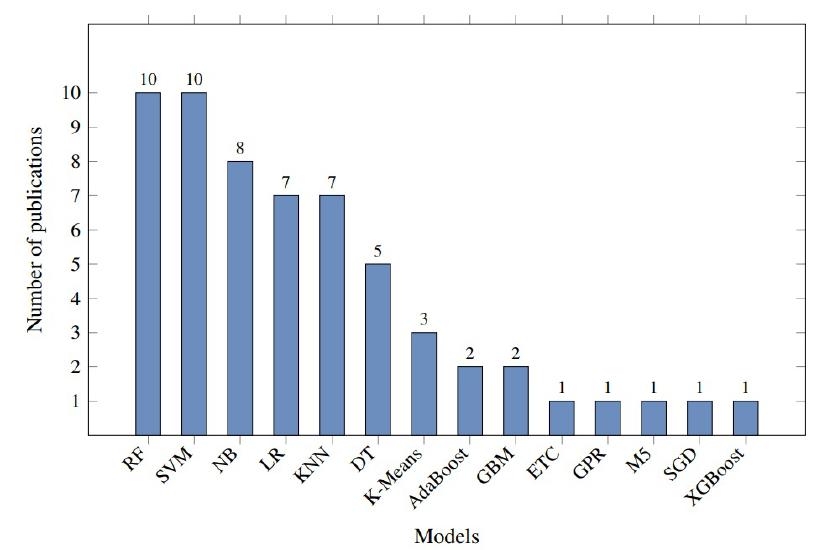
Figure 2. Distribution of machine learning-based sentiment classifiers used in learning-based ap- proaches.